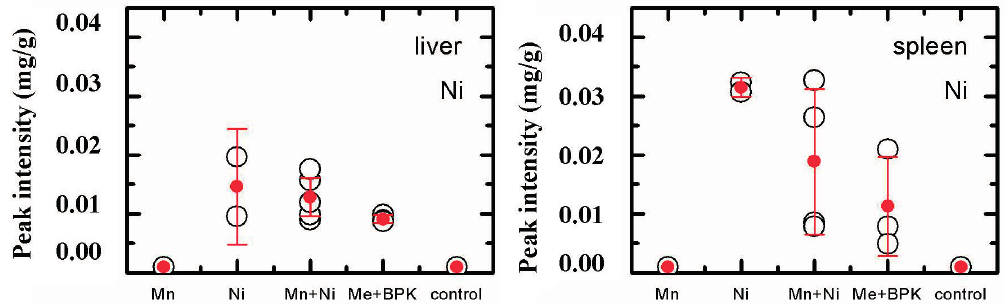
Figure 1. Nickel (as NiO-NPs) content of the liver and spleen in the groups of rats exposed to NiO-NPs, to Mn 3 O 4 -NPs + NiO-NPs, or to the same combination together with the BPC (designated as NiO-NPs, Mn + Ni and Me + BPC, respectively). Electron paramagnetic resonance (EPR) method. Dots correspond to arithmetic means; bars, to 95% CI.